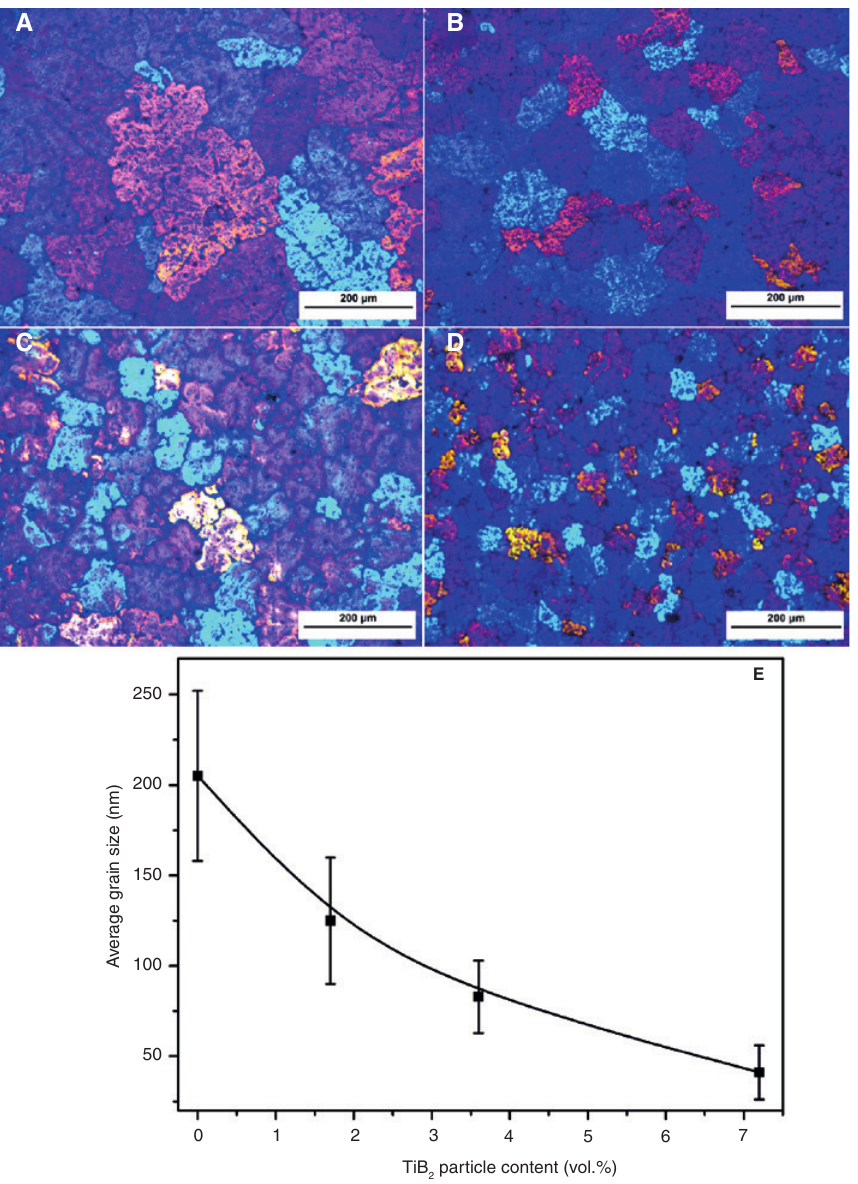
content on grain structure and size of (A) Al-4.5Cu; (B) 1.7TiB 2